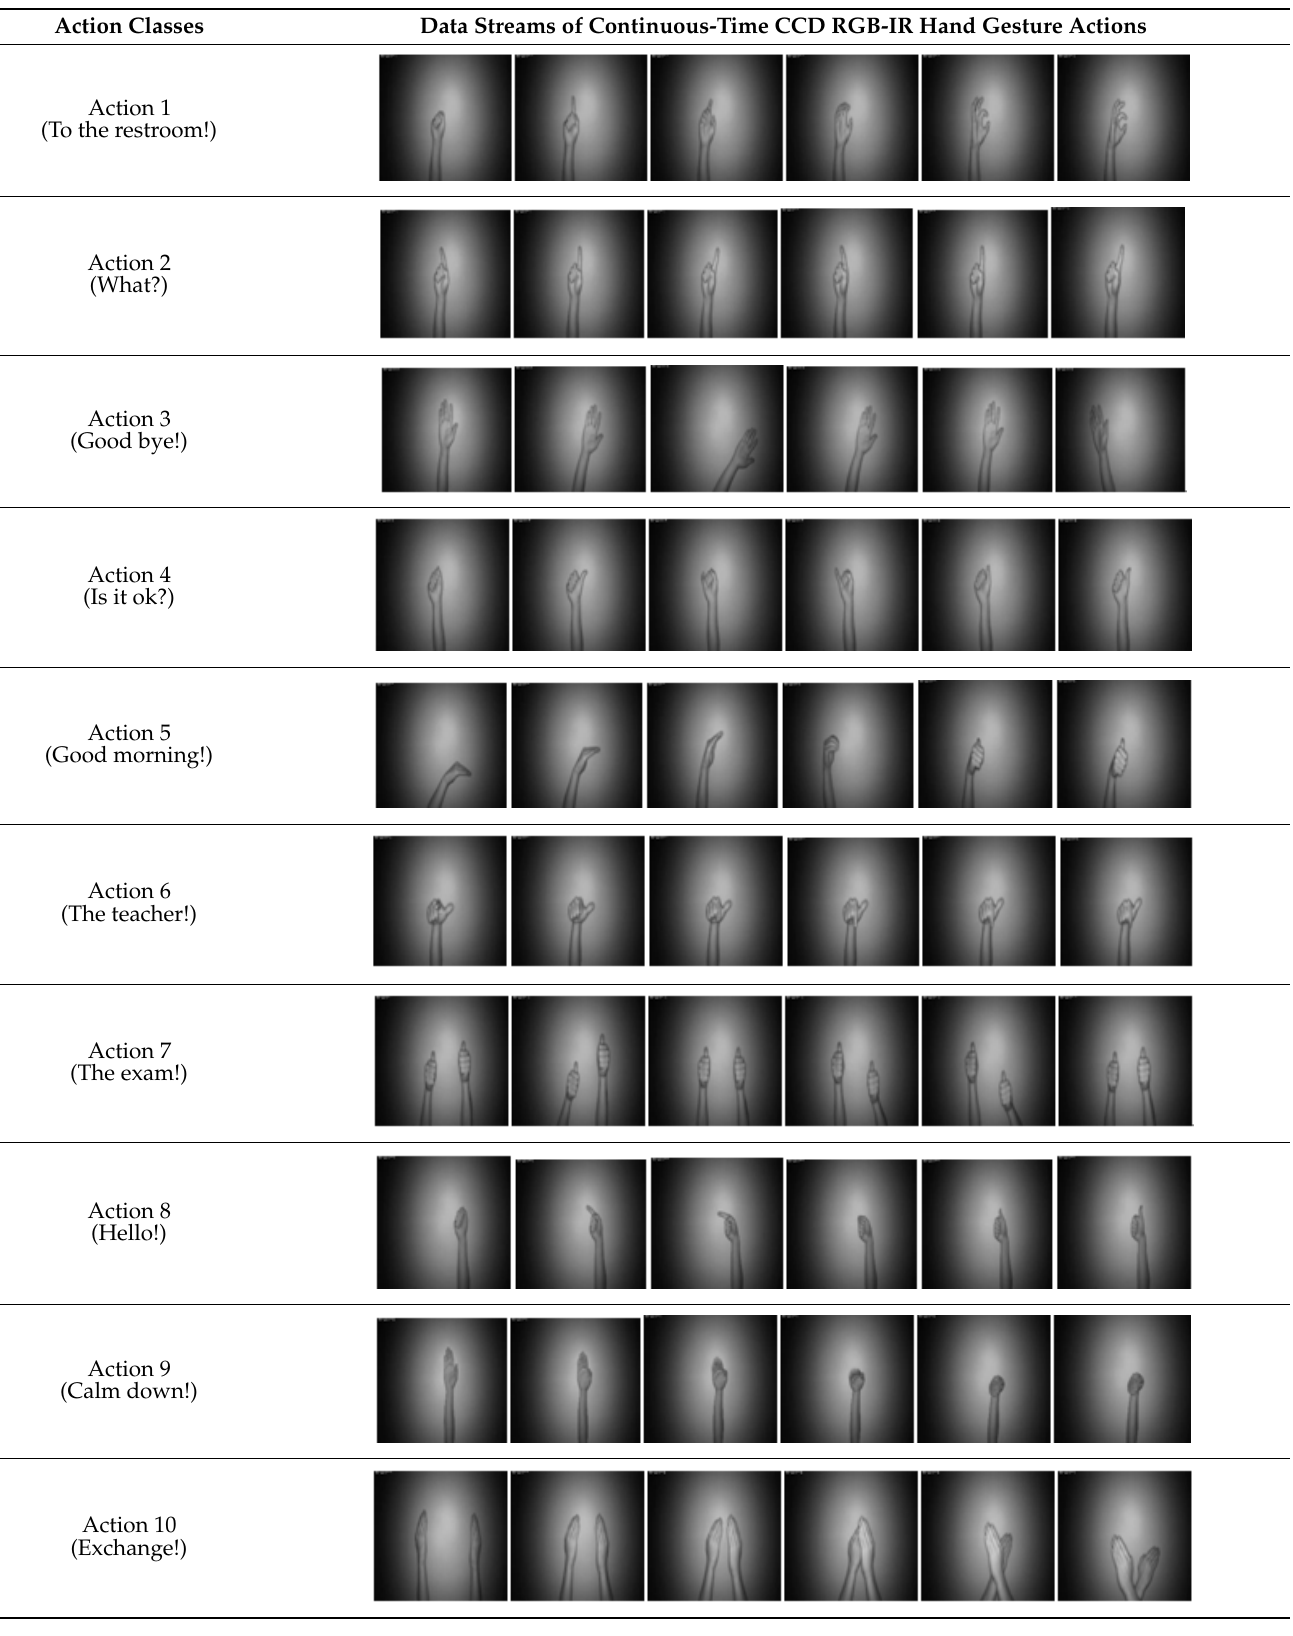
Figure 13. Acquisitions of the hand gesture intention images of different modalities of RGB-IR and depth-grayscale from a CCD camera and a Kinect device. As mentioned, this work employs 5-level wavelet image fusion for hybridizing two different sensor modality data. Before VGG-16 CNN deep learning and recognition, each of the 30,000 CCD RGB-IR action images collected was made into a wavelet image fusion of “max-min”, “min-max”, and “mean-mean” with the corresponding image of the same time-stamp in another collected set of 30,000 depth-grayscale action images. In total, there are 30,000 “max-min” wavelet fused images, 30,000 “min-max” wavelet fused im- ages and 30,000 “mean-mean” wavelet fused images for making the recognition and testing the three different VGG-16 CNN deep learning models (for each VGG-16 CNN, 15,000 action images used for model training and the other 15,000 action images used for model test). In the phase of VGG-16 CNN model training, the related hyper-parameter settings were finely made, the batch size set to 50, the learning rate set to 0.0001, the training ratio set to 0.8 and the number of epochs set to 60; in addition, for minimizing the value of the training loss, a popular optimizer, “Nesterov Momentum”, with the value of momentum set to 0.9, was also adopted in training of VGG-16 CNN. The speci- fications of the related hardware devices employed in the developed hand gesture in- tention recognition system are as follows: a desktop PC with a Windows 10 OS, equipped with an i7-8700 3.20 GHz CPU (Intel, Santa Clara, CA, USA), 16 GB RAM and a graphics card with a Geforce GTX 1080 Ti GPU (Nvidia, Santa Clara, CA, USA); a CCD camera for capturing the CCD RGB-IR hand gesture images was connected to a monitor host with four surveillance channels (only one channel used in this work). In total, 8